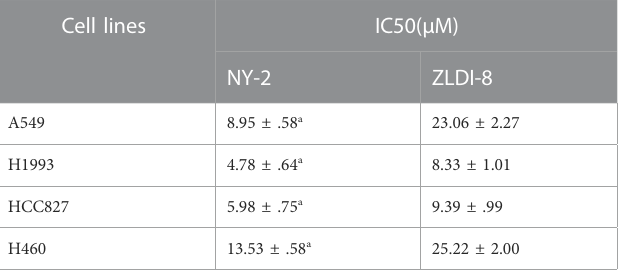
TABLE 3 IC50 values of NY-2 and ZLDI-8 on four kinds of NSCLC cells (48 h). Cell